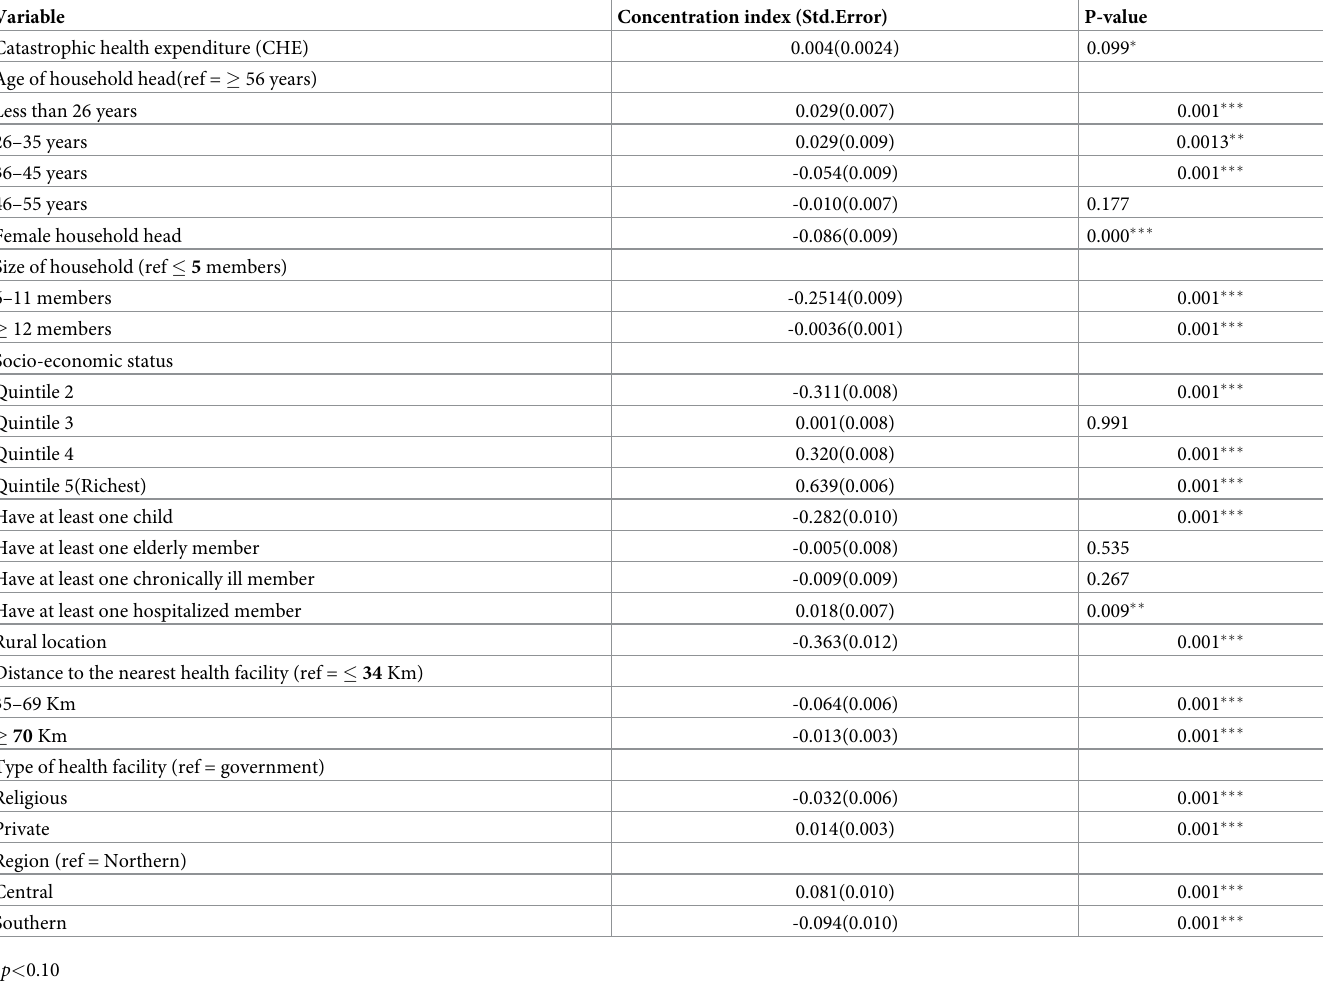
Table 2. Erreygers corrected concentration indices for catastrophic health expenditures and its